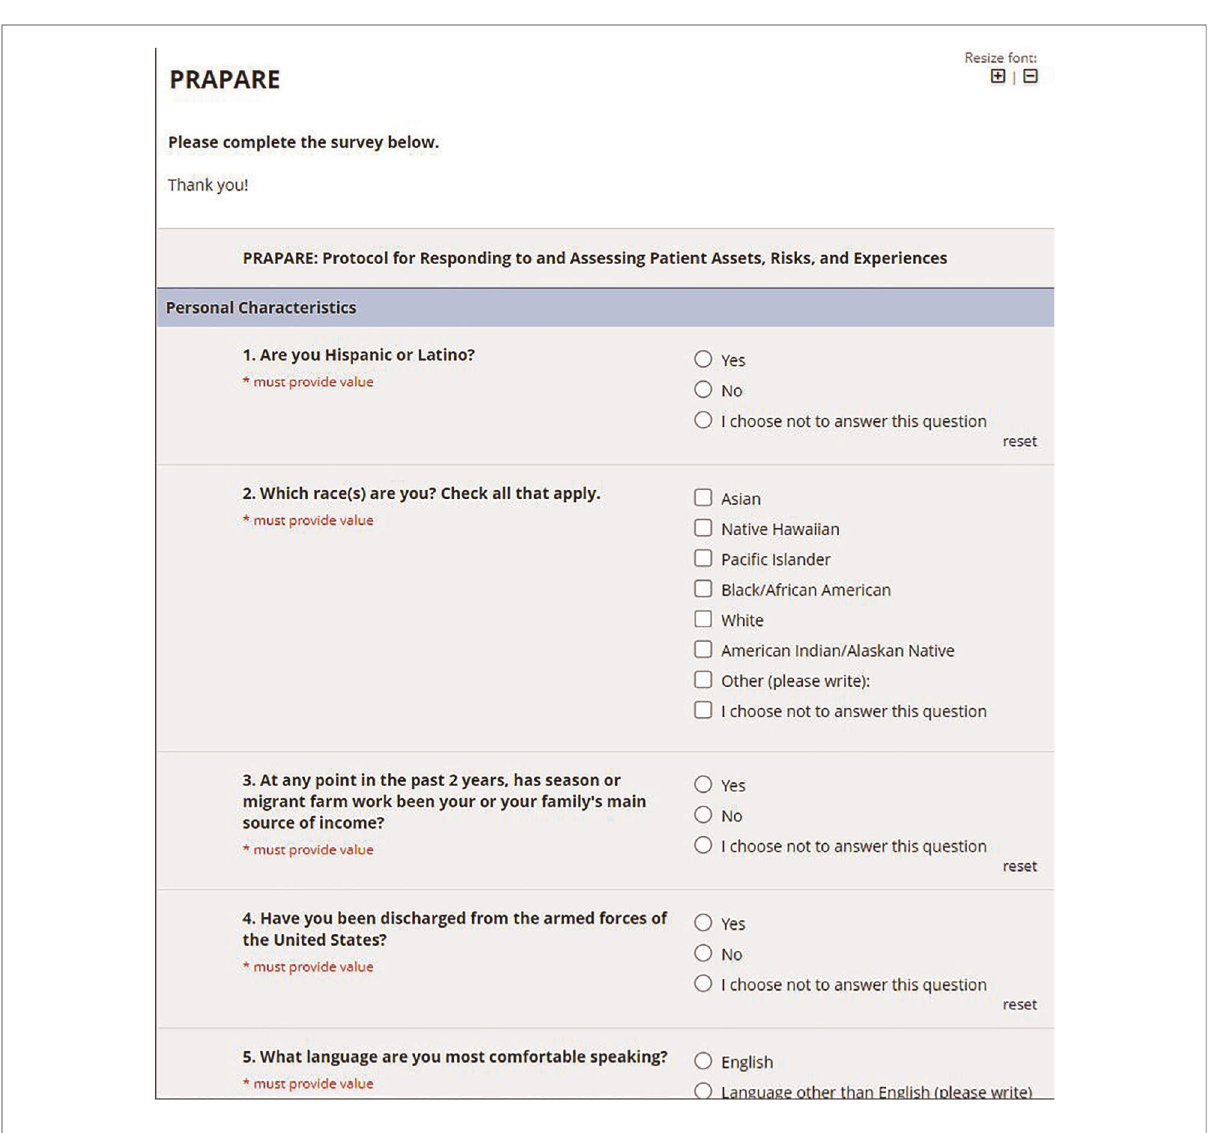
FIGURE 2 REDCap interface.